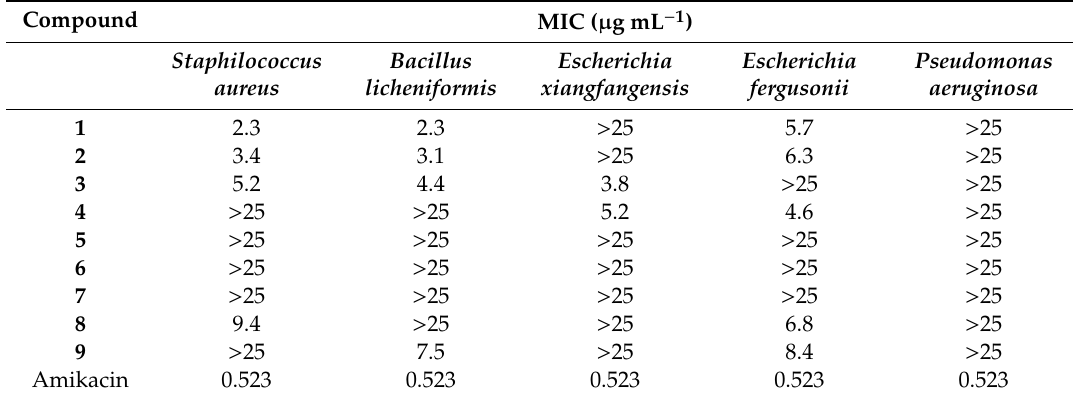
Table 3. Antibacterial activity of compounds 1–9